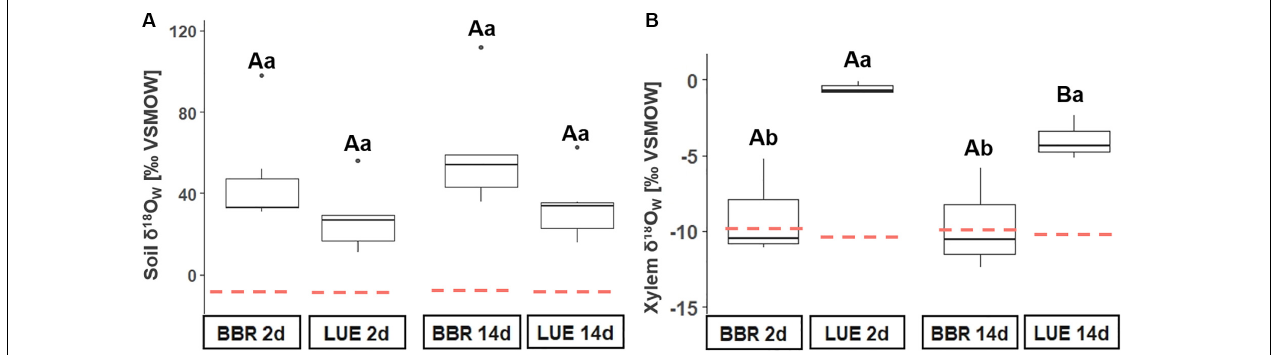
FIGURE 3 | Oxygen isotope signatures ( δ 18 O) of xylem sap water (xylem δ 18 O w , a), and soil water (soil δ 18 O w , b) of control plots on the two sampling dates (2 d and 14 d = 2 days and 14 days, respectively) after addition of 18 O-enriched water. Lowercase letters indicate significant differences between sites, whereas uppercase letters refer to significant differences between sampling dates. Red dashed lines show the background oxygen isotope signatures ( δ 18 O) before 18 O addition (A) background: BBR: –8.2